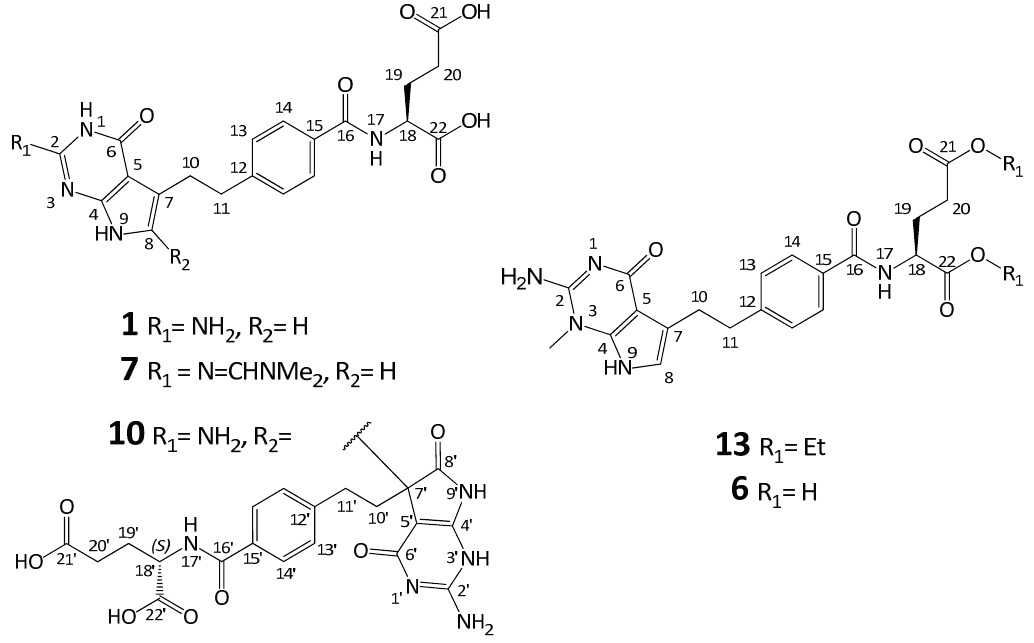
Figure 2. Numbering of atoms in the NMR spectra description for compounds 1 , 6 , 7 , 10 and 13 (Table 2). γ -Dipeptide impurity 8 and α -dipeptide impurities 9